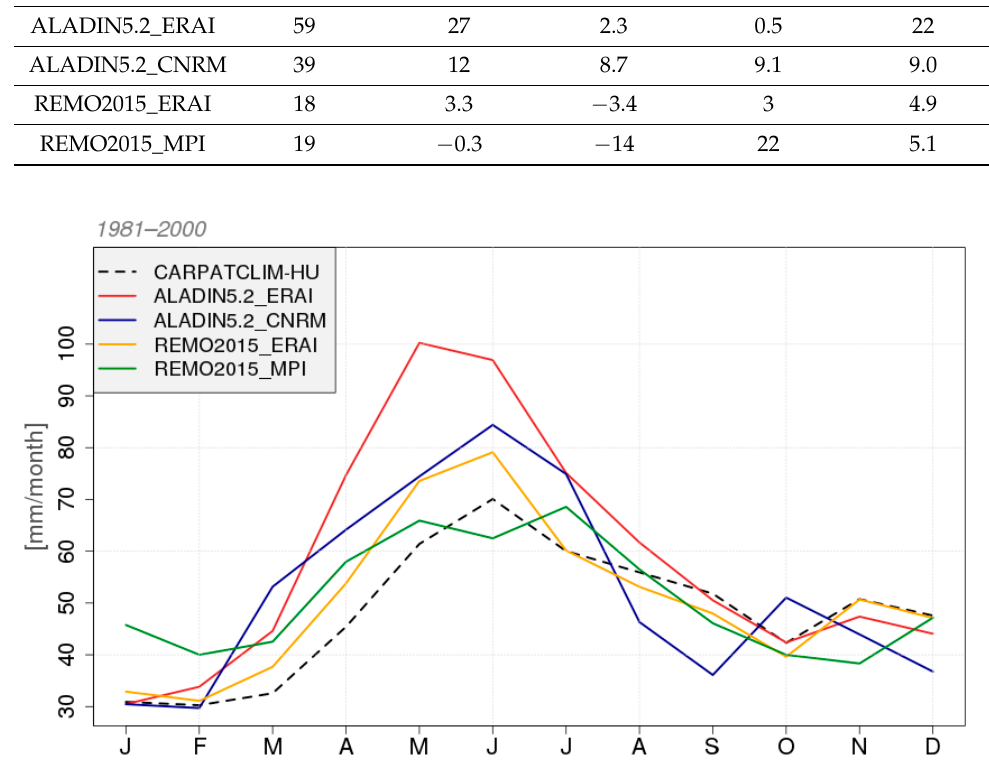
Figure 6. Monthly mean precipitation in Hungary in 1981–2000 based on the CarpatClim-HU observation dataset and the ALADIN5.2 and REMO2015 simulations. Table 6. Relative bias of seasonal and annual precipitation (%) of the four model simulations over Hungary in comparison with the CarpatClim-HU observation dataset. Period: 1981–2000.